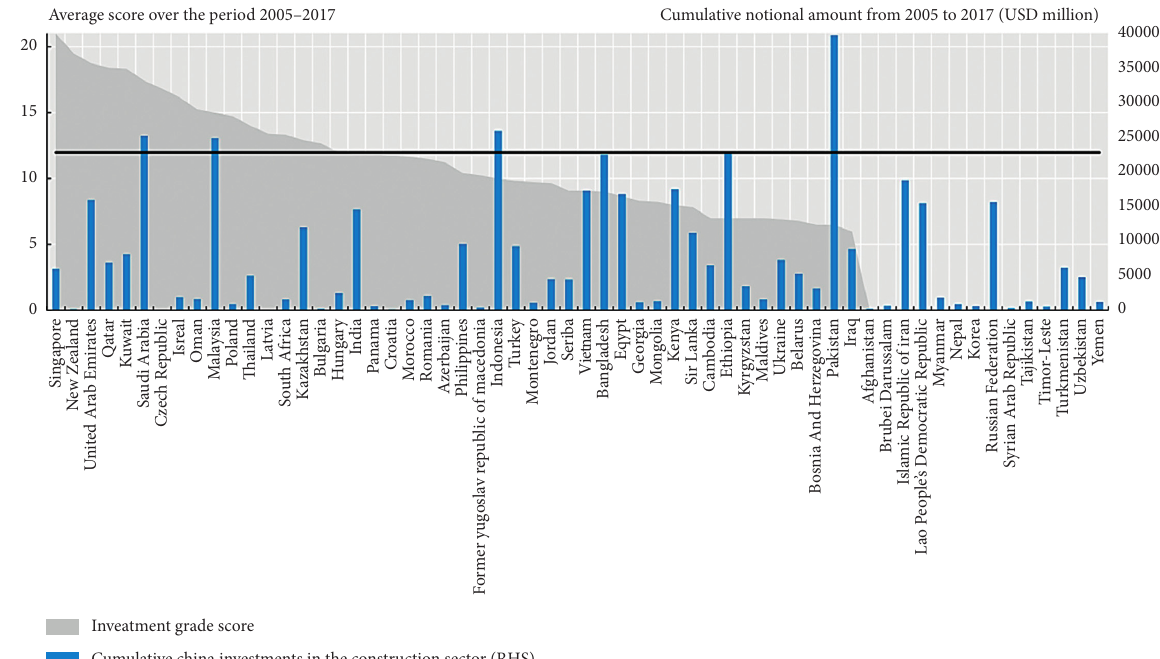
Figure 2: Investment of construction projects under BRI countries (credit rating score)